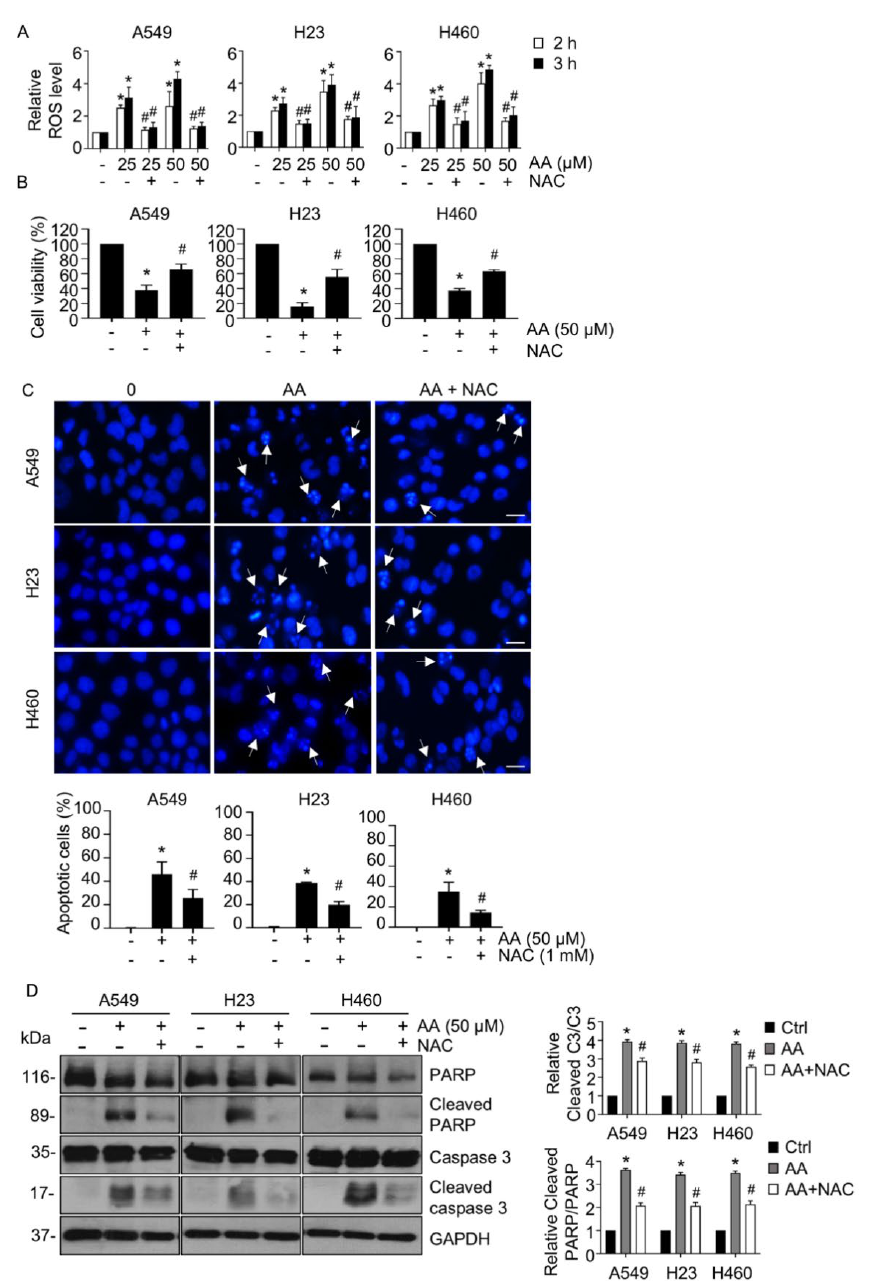
Figure 3. Aspiletrein A (AA) induced reactive oxygen species (ROS) generation. ( A ) Lung